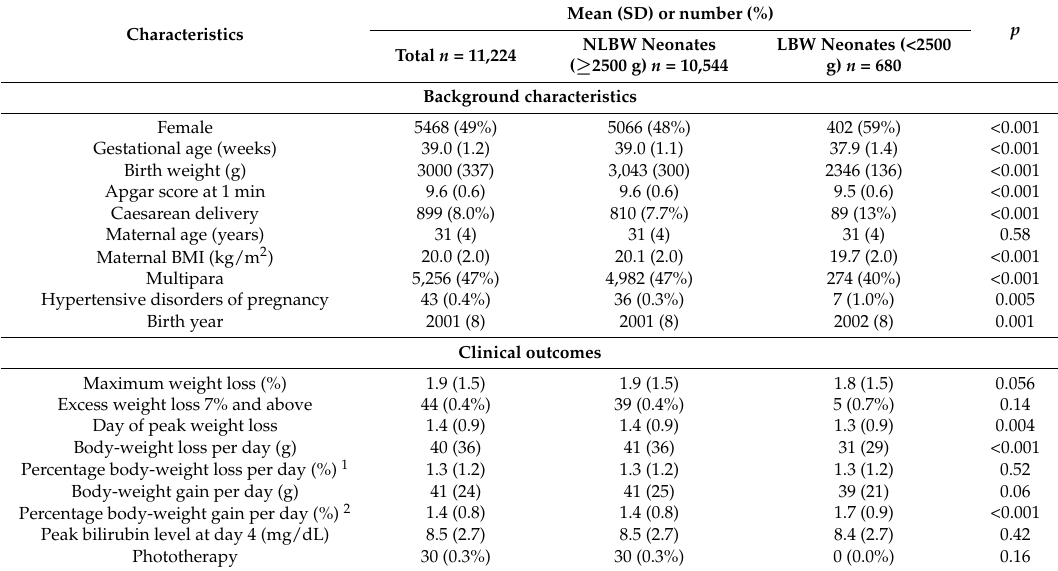
Table 1. Background and clinical characteristics of 11,224 neonates who received optimal thermal control with sufficient nutrition.